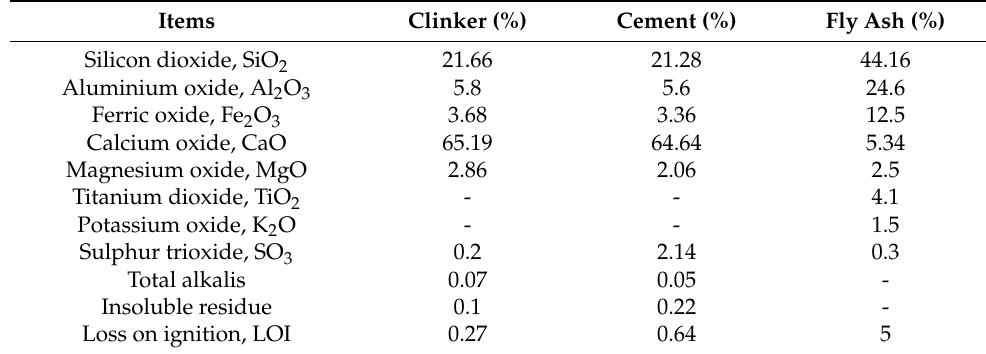
Table 1. Chemical detail of cement and fly ash materials (Adapted from